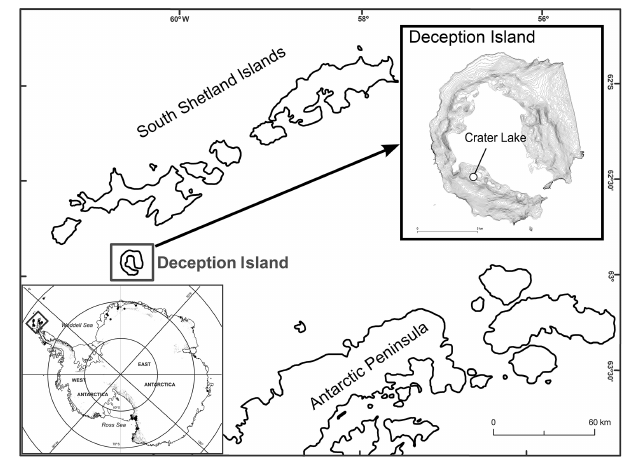
Figure 1. Location of Deception Island and Crater Lake CALM-S site in